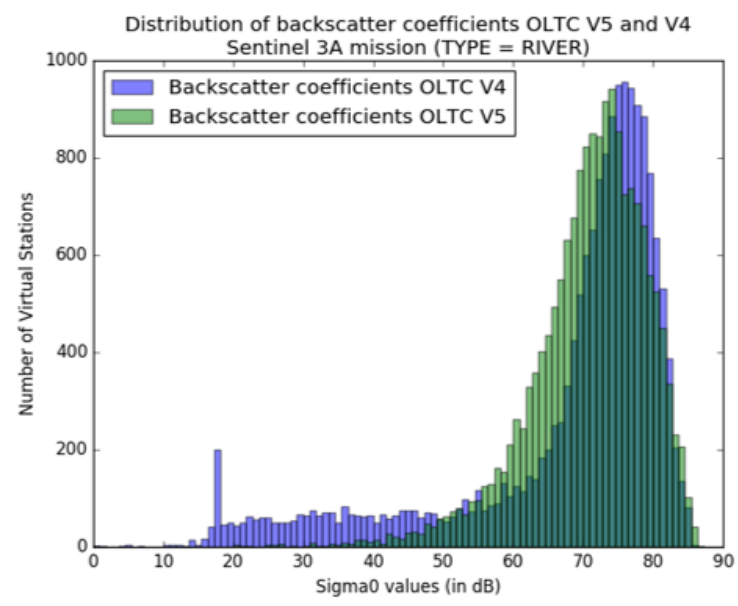
Figure 46. Distribution of σ 0 values for S3A with OLTC v4.2 (blue) and v5.0 (green) over approximately 17000 river targets.